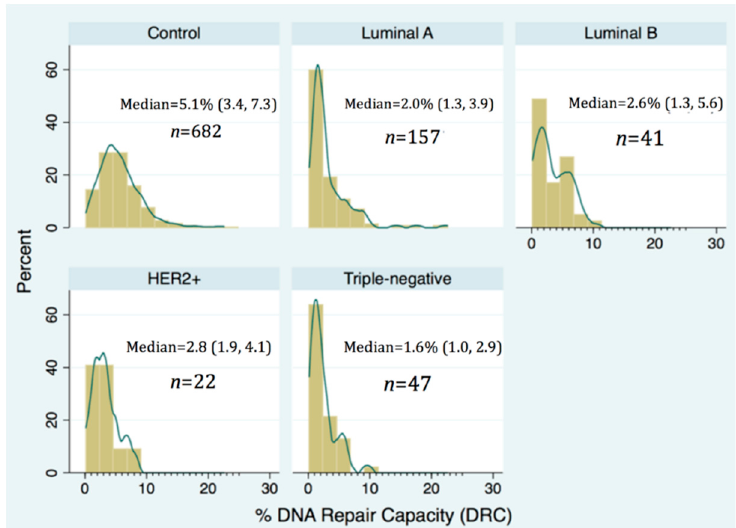
Figure 1. Distribution of DNA repair capacity (DRC) in controls and breast cancer cases stratified using the four principal molecular subtypes of breast cancer. The numbers included on each panel for each group include the median.